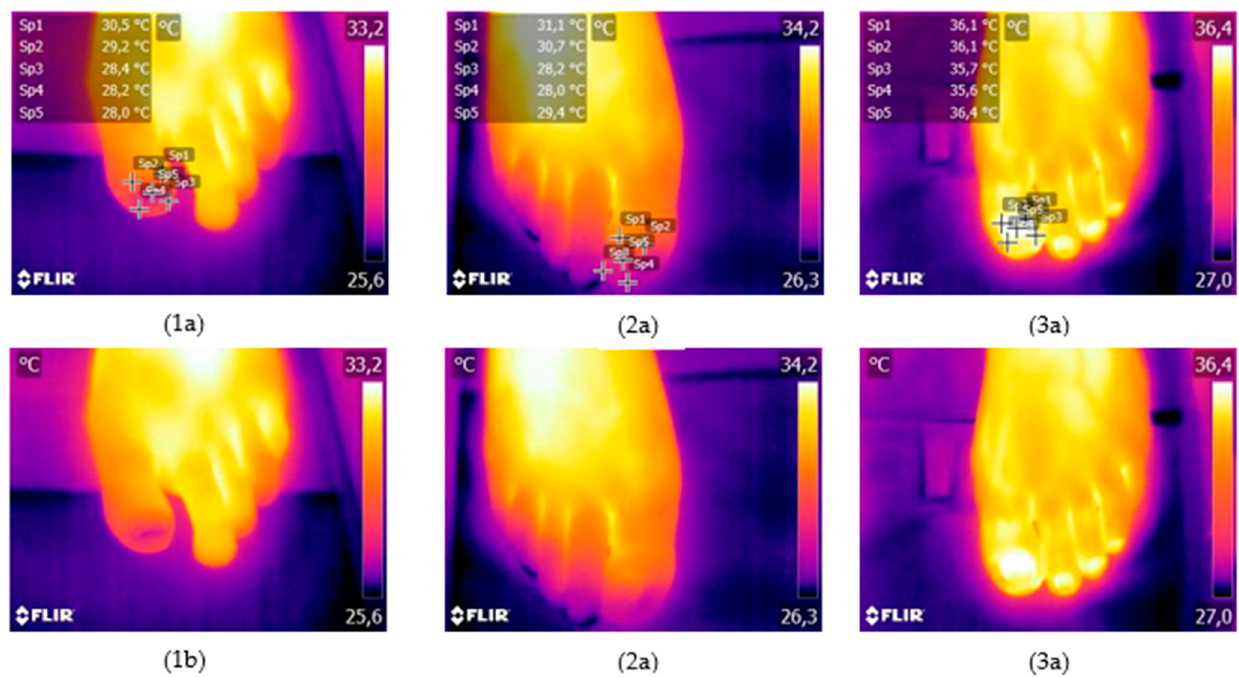
Figure 3. Non-infected nail ( 1a , 1b ), nail infected by dermatophytes ( 2a , 2b ) and yeast ( 3a , 3b ). Table 2. Descriptive analysis of thermography variables. N =